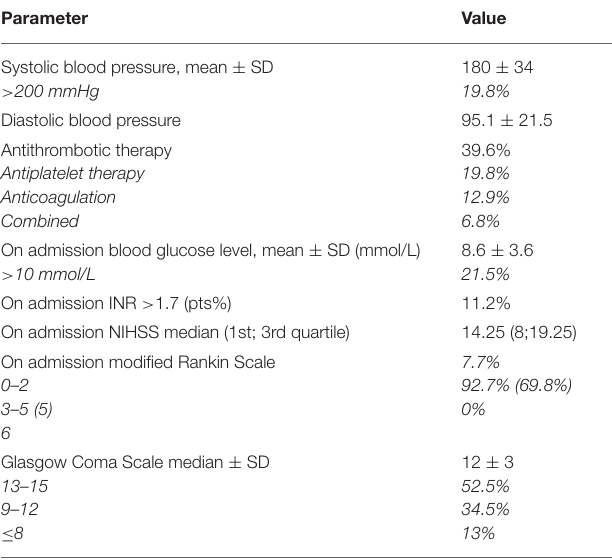
TABLE 2 | Summary of on-admission parameters ( N = 116), including scales (modified rankin scale on admission and glasgow coma scale, NIHSS scale).